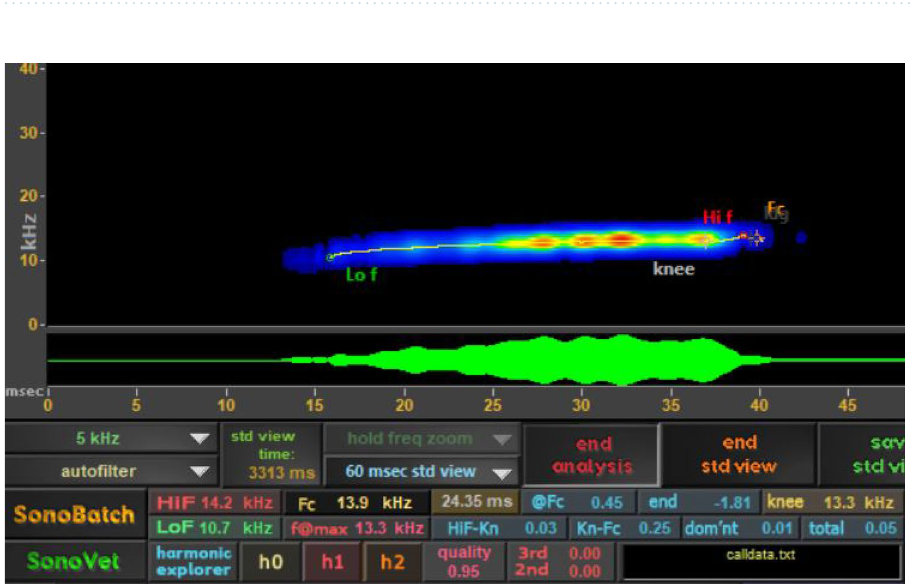
Figure 2. Typical hoary bat ( Lasiurus cinereus ) social call, showing upsloping call shape, and parameters used to describe calls displayed in SonoBat. Time in milliseconds is on the x axis, and frequency in KHz on the Y axis, displayed in